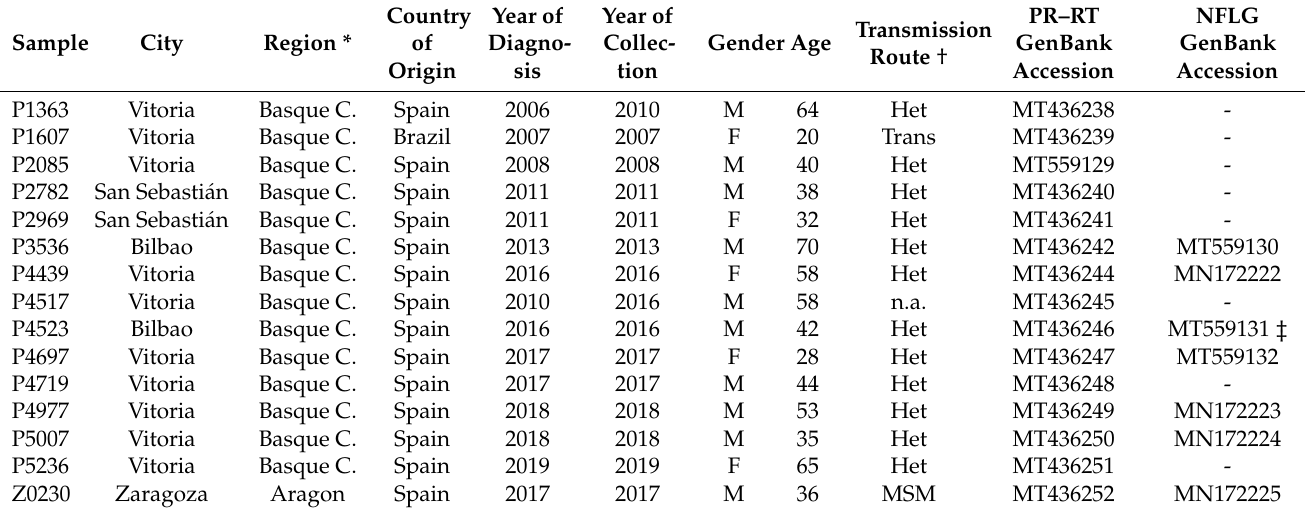
Table 1. Epidemiological and clinical data of the patients and GenBank accessions of